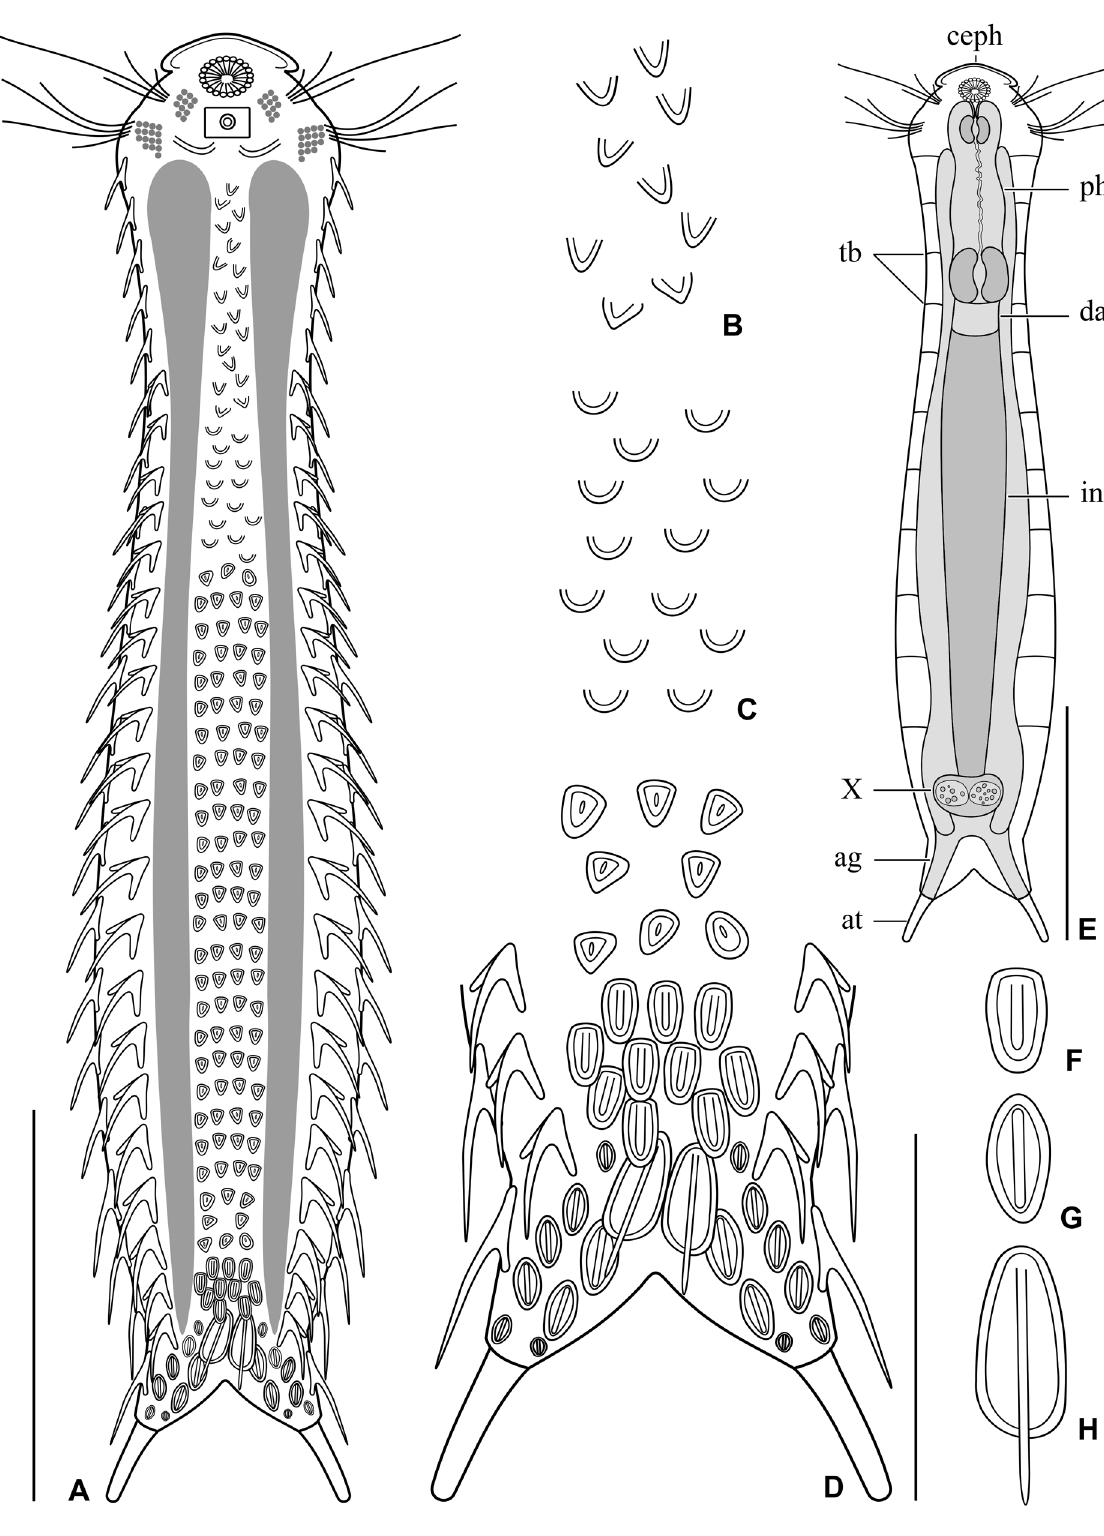
Fig. 19. Chaetonotus ( Hystricochaetonotus ) optabilis sp. nov. A . Ventral overview showing the scale and ciliary pattern. B . V-shaped scales without keels. C . Bowl-shaped scales without keels. D . Detail of the ventral posterior body region. E . Internal morphology. F . Narrowly obovate keeled scale. G . Fusiform keeled scale. H . Oblong spined scale. Scale bars: A, E = 30 µm; D = 10